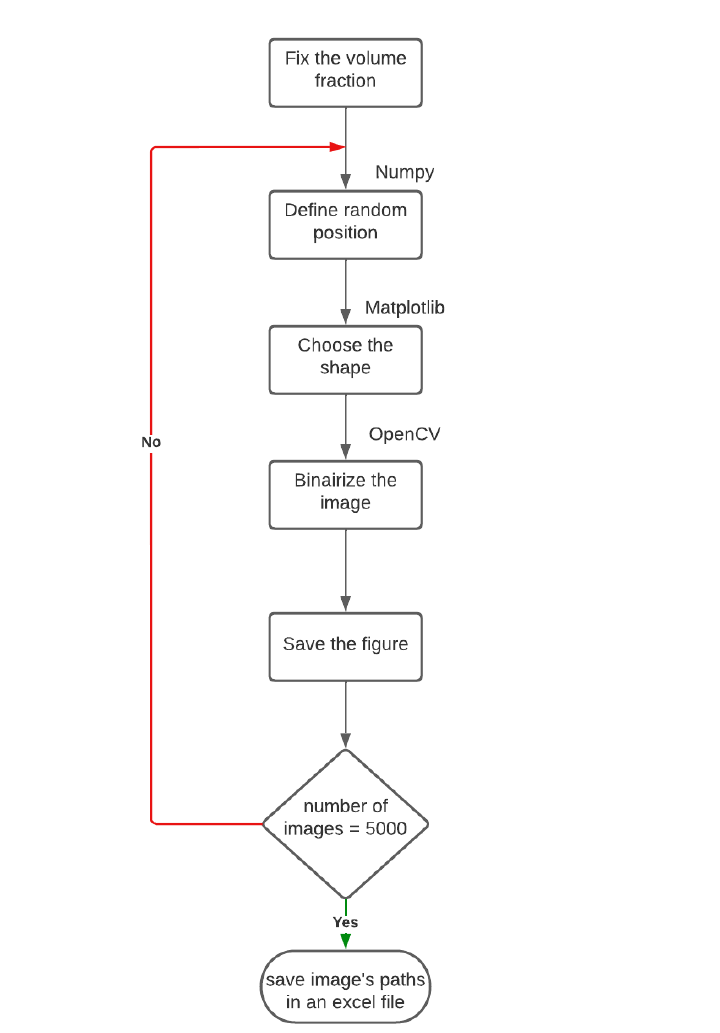
Figure 1. Descriptive flowchart of the data collection process through a python script based on the use of Matplotlib and